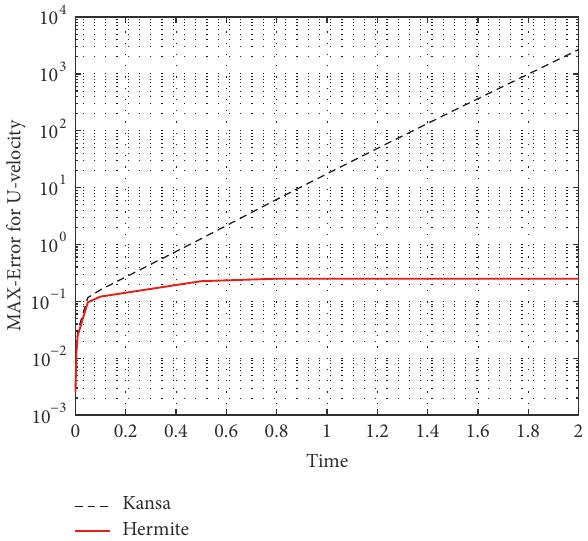
Figure 9: 𝐿 ∞ -error progression in time (0.00 ≤ 𝑡 ≤ 2.00) of the U-maximum error comparison computed at Re = 1,300 with 𝜀 = 0.005,Δ𝑡 = 0.0005 , and 𝑁 = 10 × 10 .